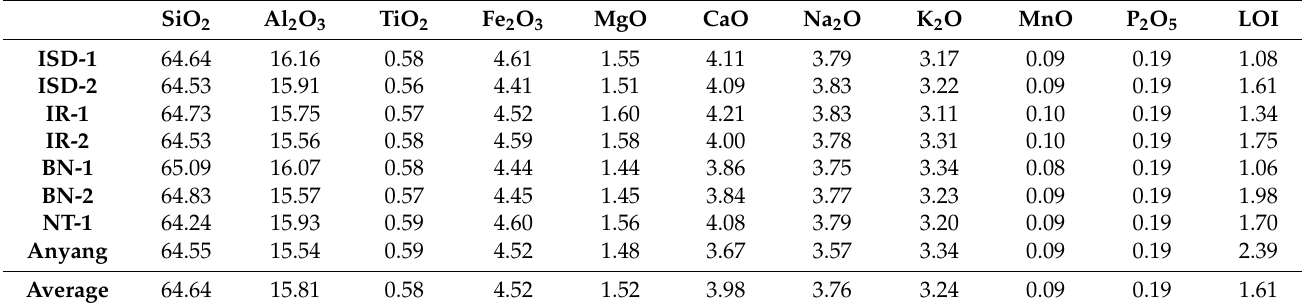
Table 1. Major element compositions of the Mudeungsan tuff samples (in